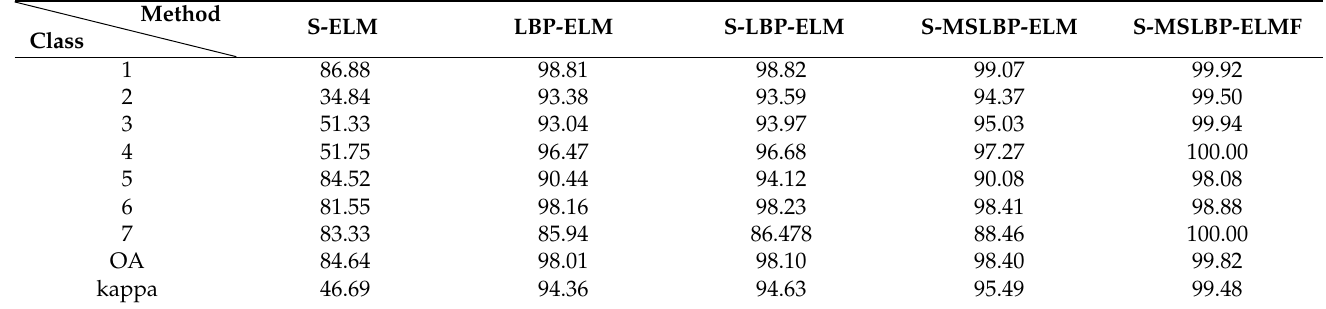
Table 6. Interpretation accuracies of different methods on ecological restoration areas dataset (%).